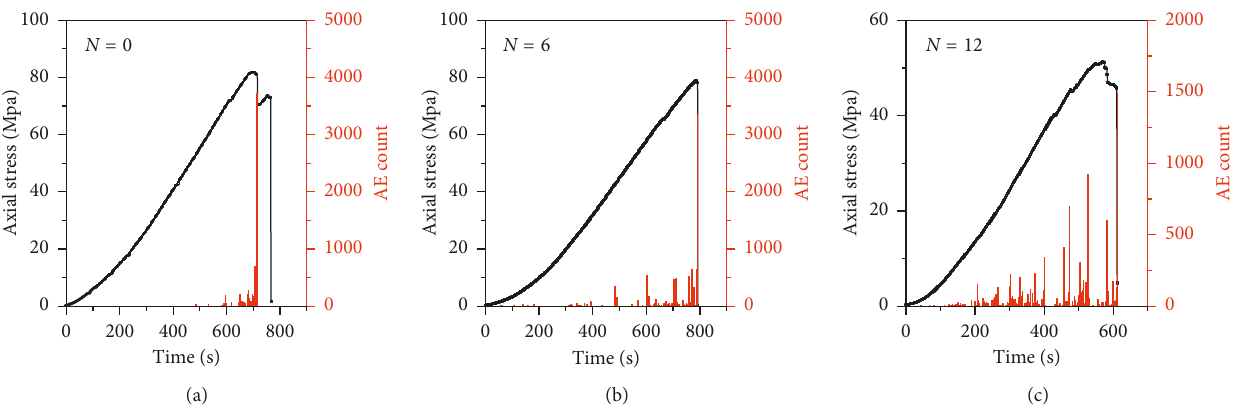
Figure 9: AE count distributions of the argillaceous limestone specimens in the loading process of uniaxial